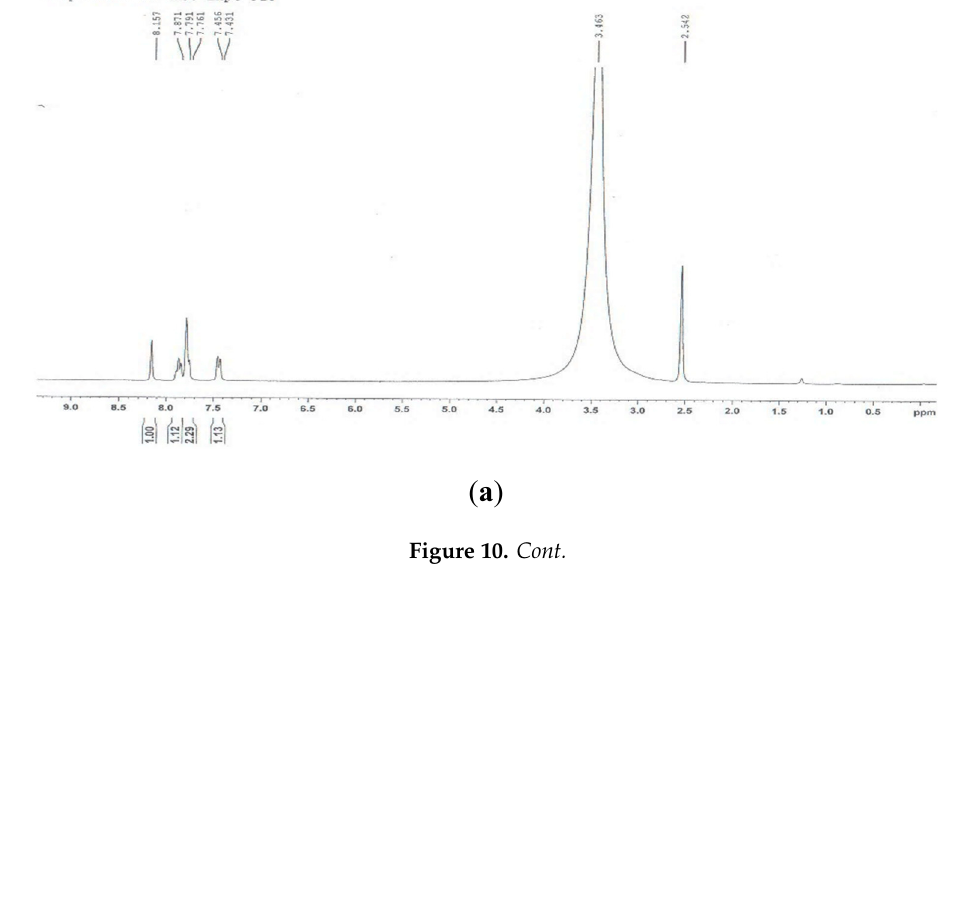
Figure 9. HPLC chromatograms of rhein sample ( a ) before and ( b ) after purification.